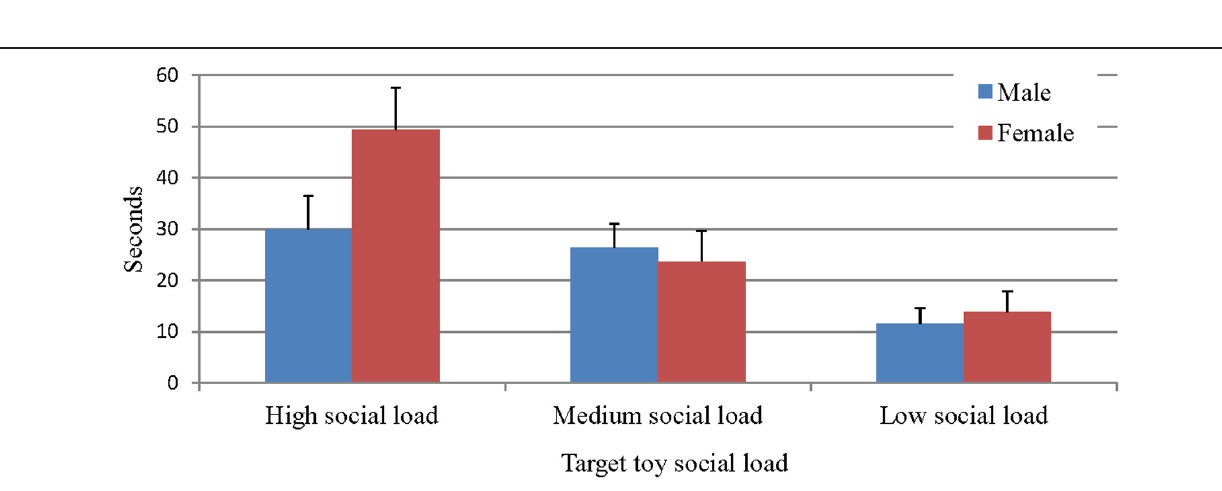
FIGURE 4 | Time of positive affect as a function of gender and social